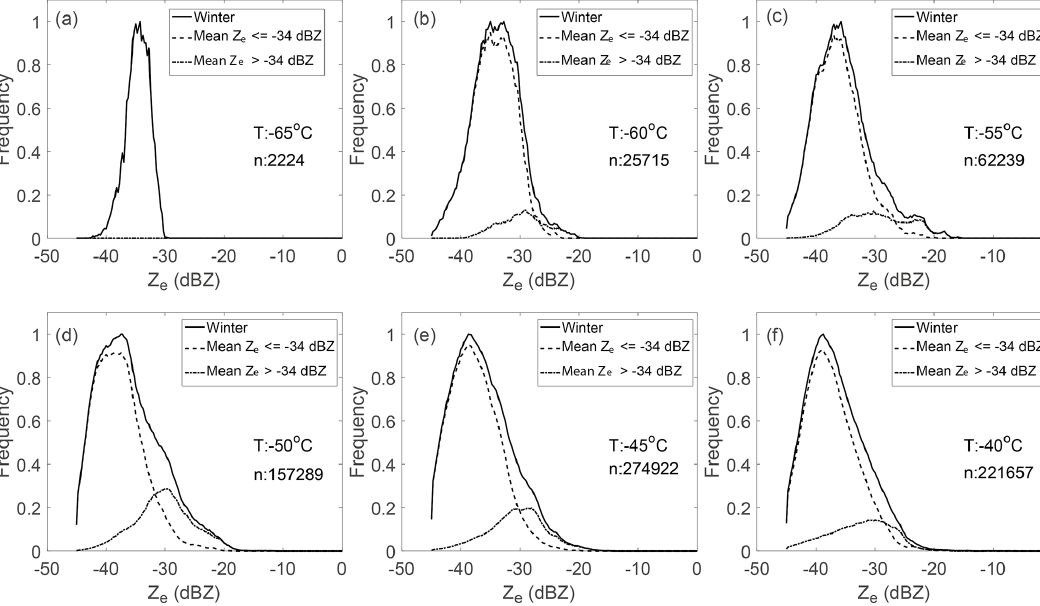
Figure 11. As in Fig. 8 but for